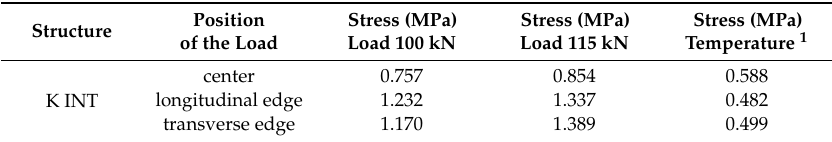
Table 3. Calculated stress in concrete slab structure K INT.